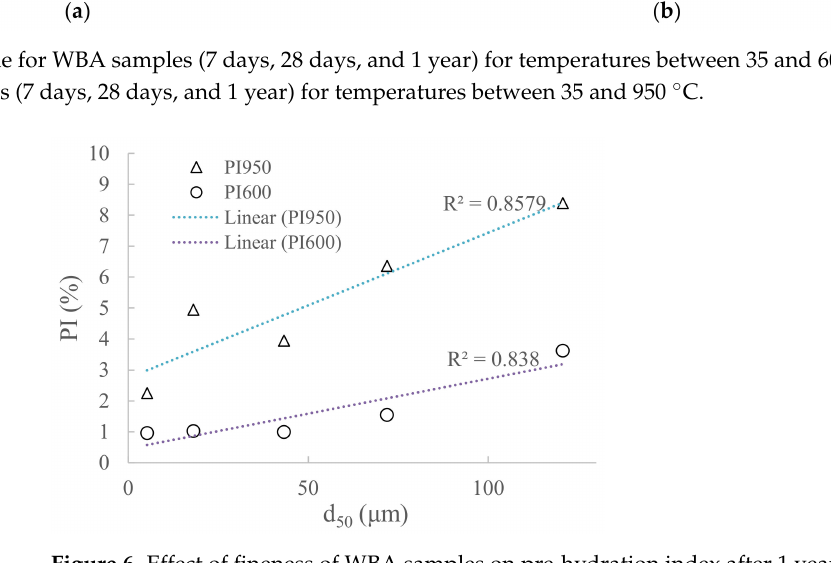
Figure 6. Effect of fineness of WBA samples on pre-hydration index after 1 year (PI 950 and PI 600